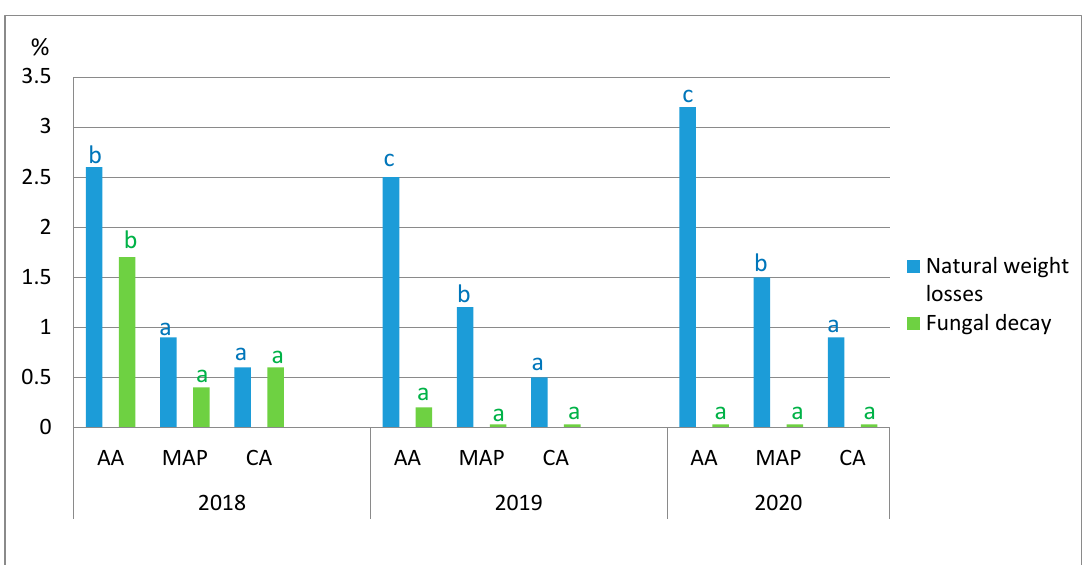
Figure 3. Natural weight losses (%) and fungal decay (%) of ‘Albion’ strawberries as affected by storage conditions. Bars characterizing fungal decay should be green (like the letters) blue letters and bars refer to weight mass